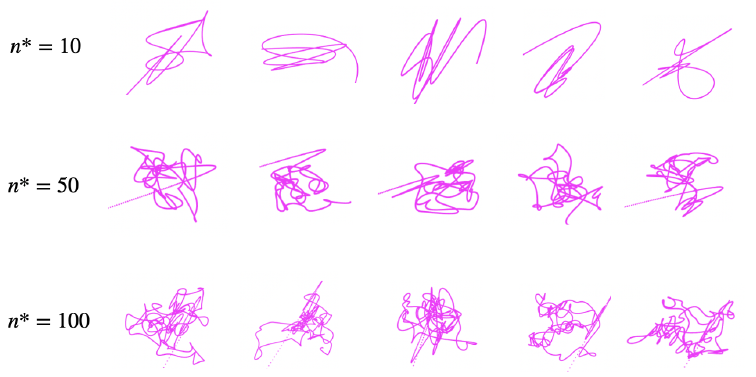
Figure 2 . Examples of 3D string profiles for different combinations of harmonics n ∗ = 10 , 50 , 100 . For each value of n ∗ there are five choices of string profiles for different choices of uniformly dis- tributed random parameters a j ∈ (0 , 1) n